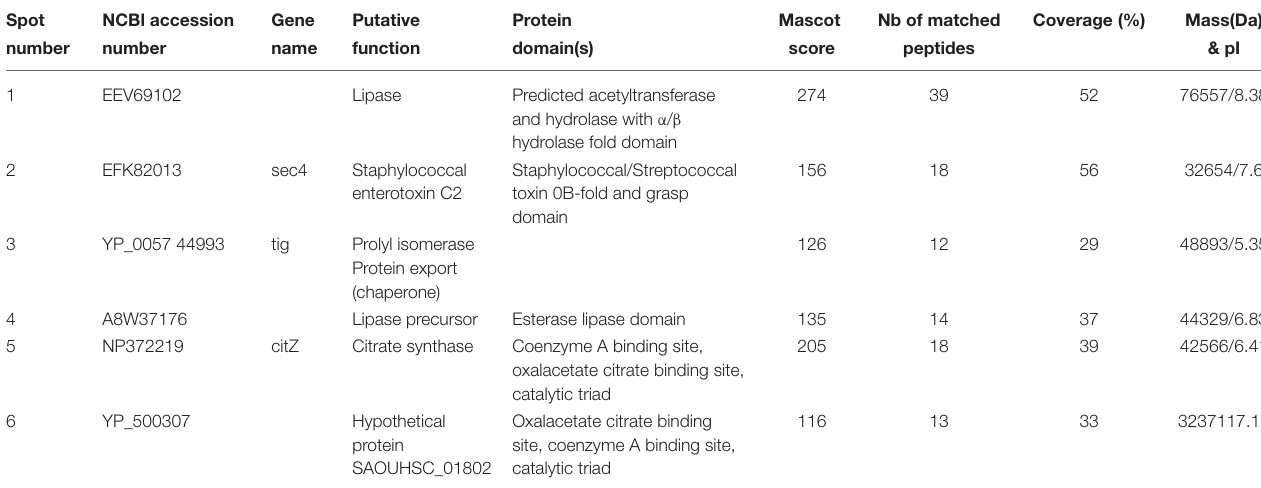
TABLE 2 | Proteins under- and over-expressed in the secretome of Substance P treated S . aureus MFP03 identified by